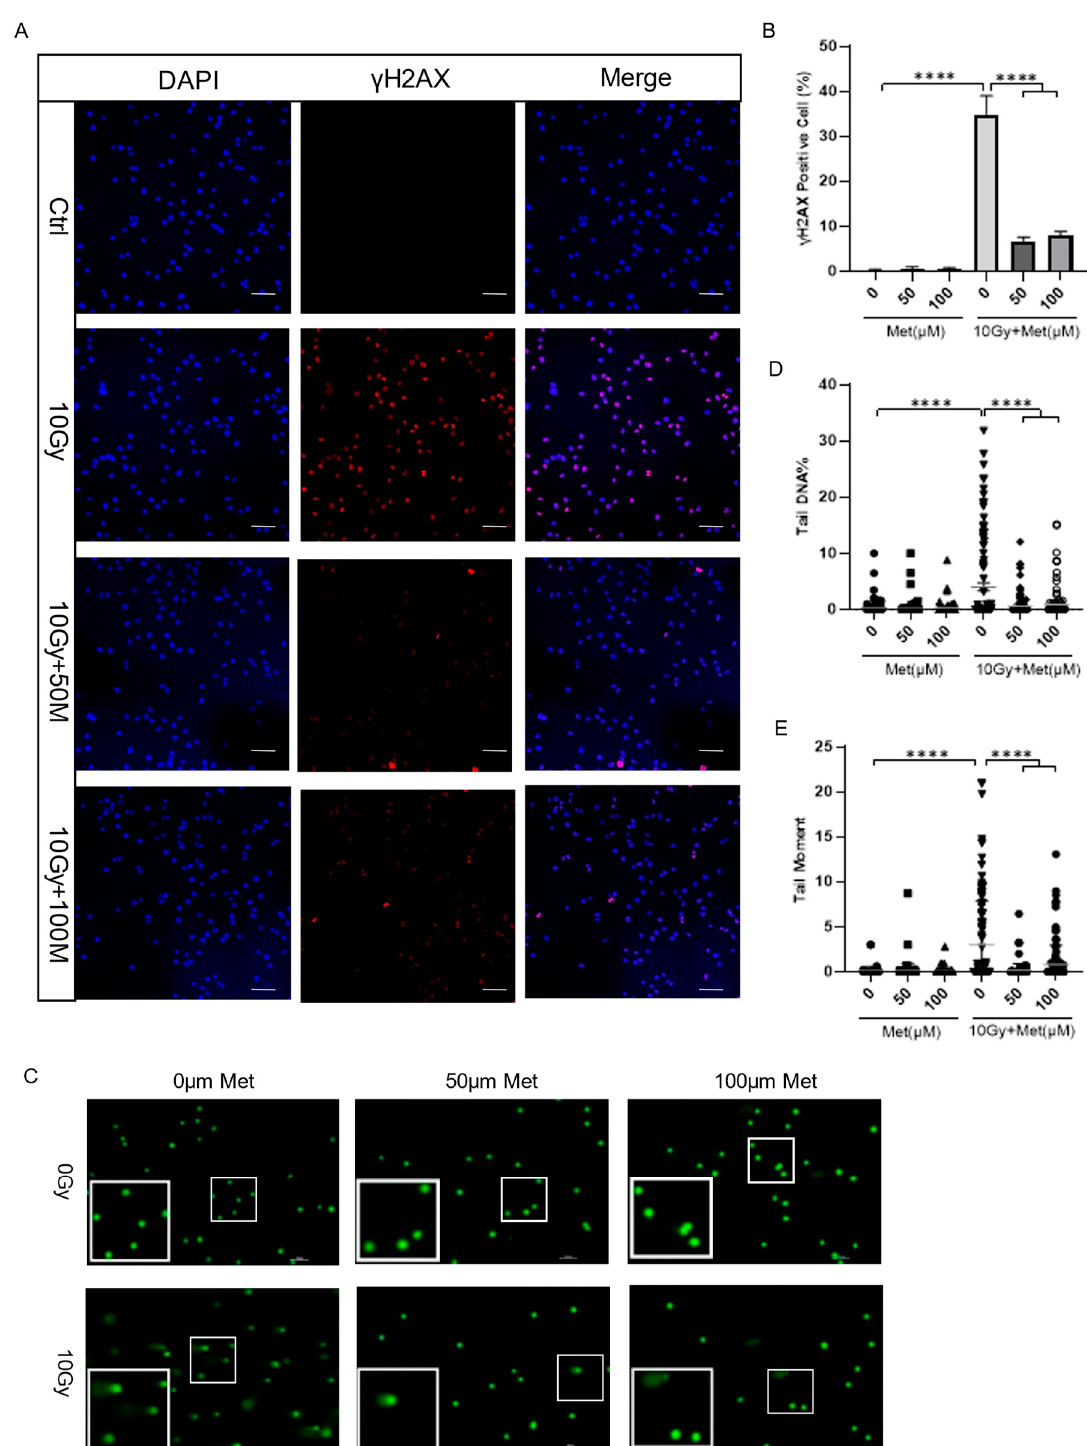
Figure 5. Metformin reduces DNA damage in BV2 cells by γ -H2AX immunostaining assays and comet assays. ( A ) Representative immunofluorescence visual field map in BV2 cells after 10 Gy irradiation. ( B ) The quantitative data of the number of γ H2AX-positive cells in immunofluorescence after irradiation are expressed as the ratio of the number of γ H2AX-positive cells to the number of DAPI-positive cells in the visual field. Met, metformin. ( C ) Representative images of comet electrophoresis in BV2 cells after 10 Gy irradiation. ( D , E ) Quantitative analysis and statistics of percentage of DNA in the tail (tail DNA%) ( D ) and tail moment ( E ) in the comet electrophoresis experiment. **** p < 0.0001.